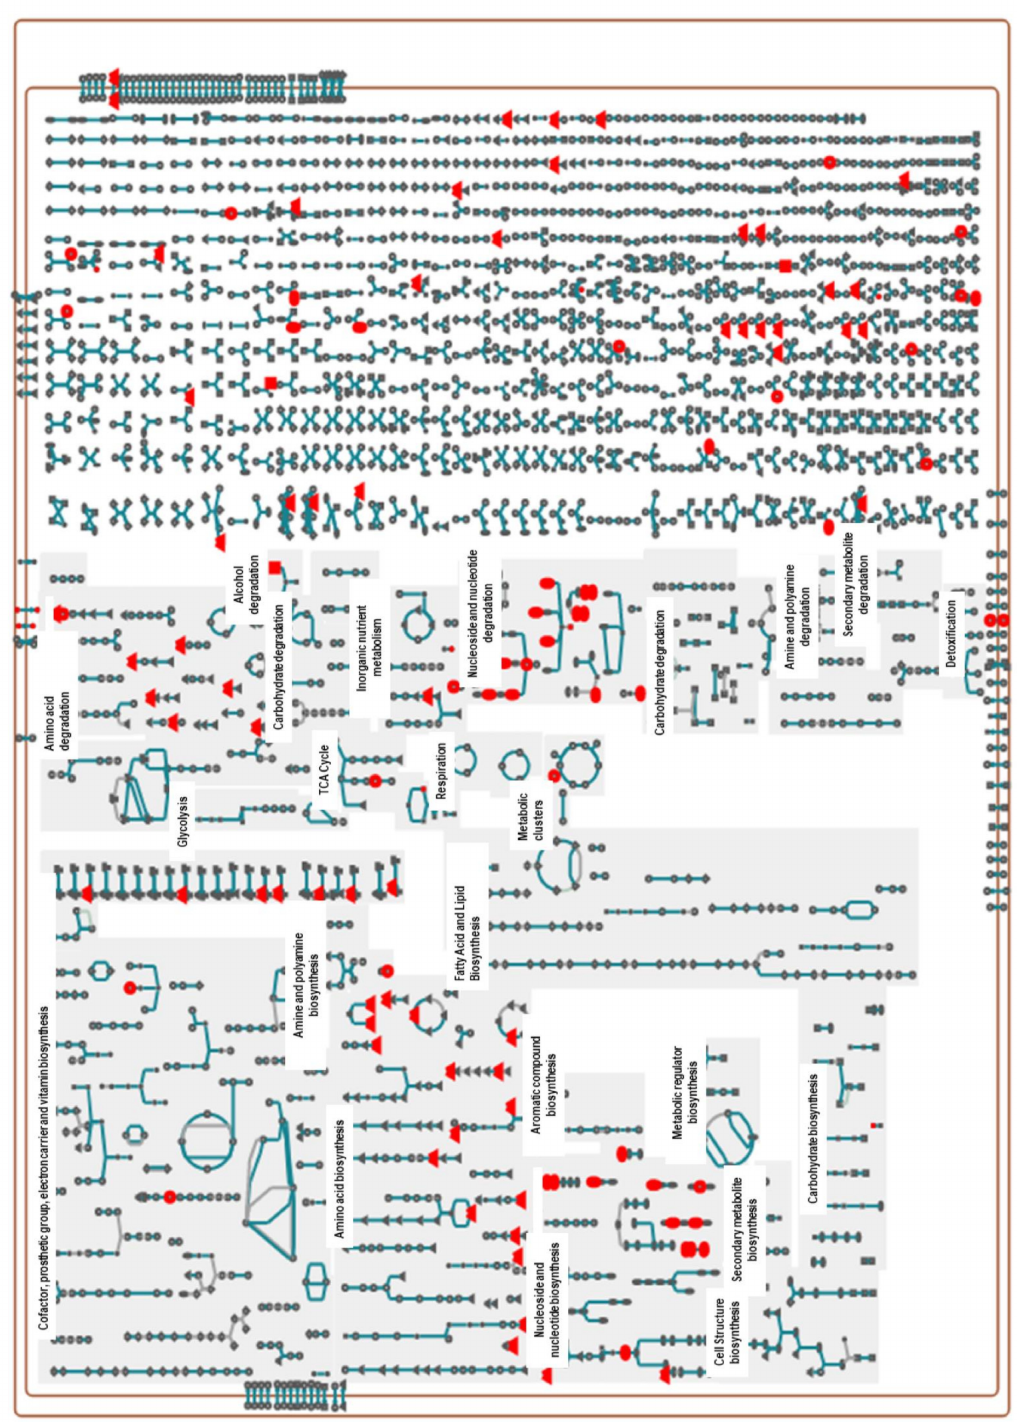
Figure 3. Metabolic pathways of X. perforans showing pathways of interaction of some of the annotated significant metabolites in the negative ion phase when the metabolites are superimposed on the cellular metabolic map of strain Xp91-118. Similarly, 34 metabolites out of the 86 significant metabolites from our dataset were annotated on the cellular metabolic map of Xp91-118 on BioCyc. These metabolites include malate, UMP, xanthine, uracil, hypoxanthine, CMP, cytidine, L-glutamine, guanosine, L-histidine, 5-aminolevulinate, L-serine, D-ribose 5-phosphate, urocanate, L-asparagine, adenosine, L-kynurenine, pyridoxine, L-proline, succinate, L-methionine, taurine, (indol-3-yl)acetate, L-cystathionine, glutarate, L-cysteate, sulfate, a carboxylate, L-ornithine, glycerol, L-saccharopine, uridine, and phosphate (pointing up triangles = Amino acids, Square = Carbohydrates, Vertical ellipse = Purines, Horizontal ellipse = Pyrimidines, Circle = Other metabolites. Analysis was carried out using the BioCyc